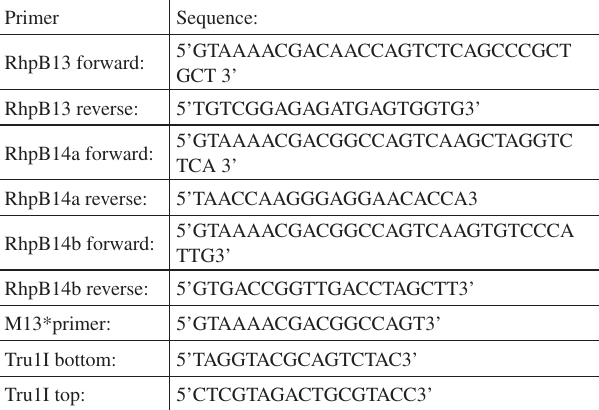
Table 2. Sequences of the used and designed